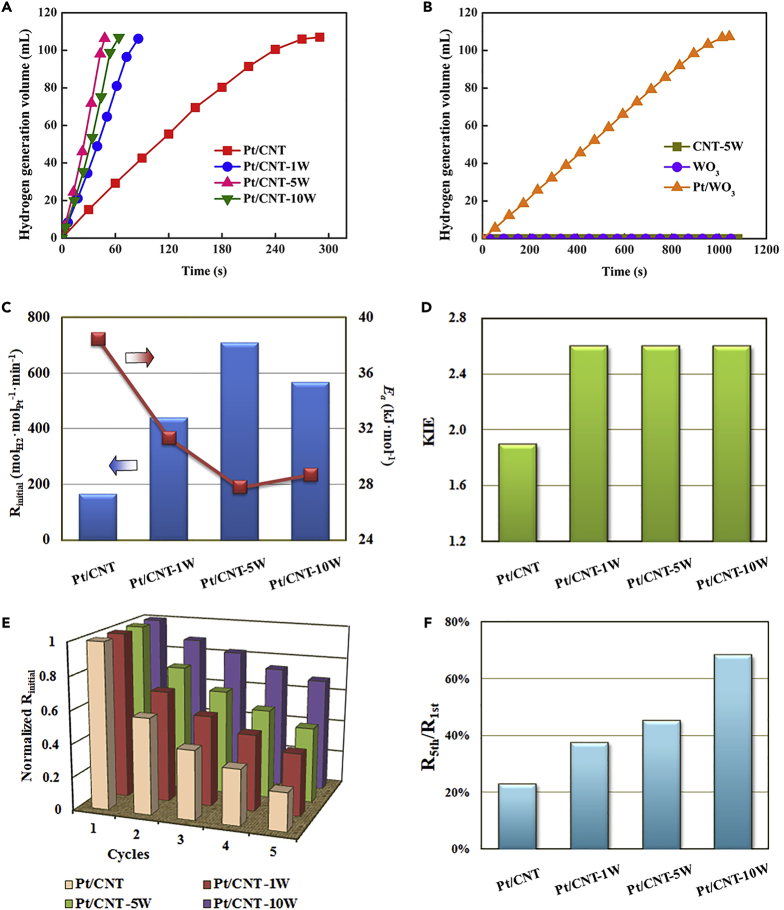
Catalytic Activity and Durability as well as Kinetics Analysis(A) Hydrogen generation as a function of time for Pt/CNT, Pt/CNT-1W, Pt/CNT-5W, and Pt/CNT-10W at 30°C.(B) Hydrogen generation as a function of time for CNT-5W, WO3, and Pt/WO3 at 30°C.(C) Rinitial and Ea of Pt/CNT, Pt/CNT-1W, Pt/CNT-5W, Pt/CNT-10W, and CNT-5W.(D) Kinetic isotope effect (KIE) values of Pt/CNT, Pt/CNT-1W, Pt/CNT-5W, and Pt/CNT-10W.(E) The relative activities over cycles of Pt/CNT, Pt/CNT-1W, Pt/CNT-5W, and Pt/CNT-10W.(F) The ratio of the activity in the fifth cycle to that in the first run, R5th/R1st, for Pt/CNT, Pt/CNT-1W, Pt/CNT-5W, and Pt/CNT-10W.